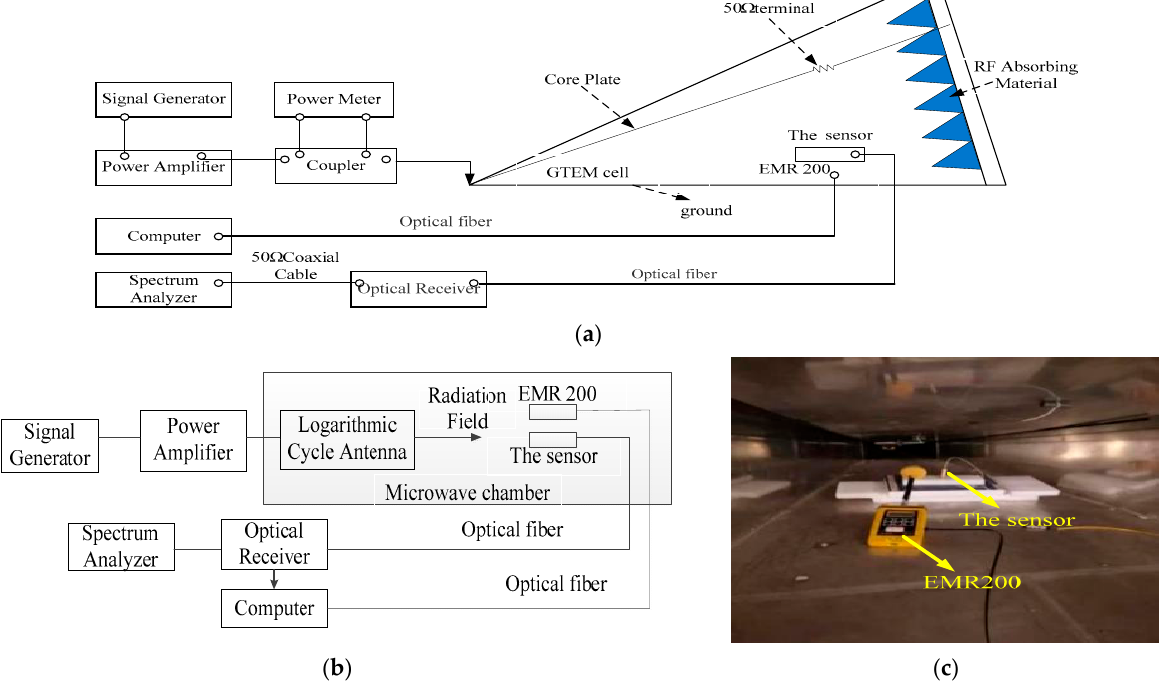
Figure 11. The test configuration diagram of low frequency (100 kHz–450 MHz) ( a ) and high frequency (450 MHz–1 GHz) ( b ) and the location photo of EMR200 and the sensor in GTEM cell ( c ).